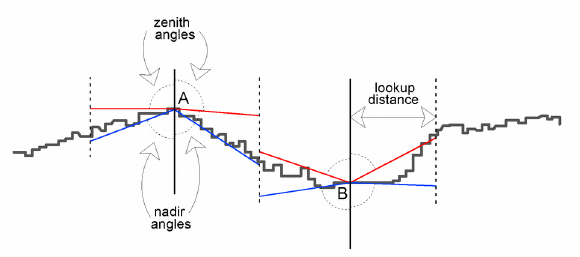
Figure 2: Main concepts of the geomorpon algorithm: zenith and nadir angles.